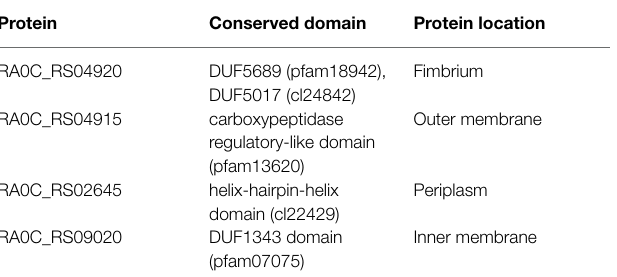
TABLE 3 | Prediction of the protein location of RA0C_RS04920 , RA0C_ RS04915 , RA0C_RS02645 , and RA0C_RS09020. Protein